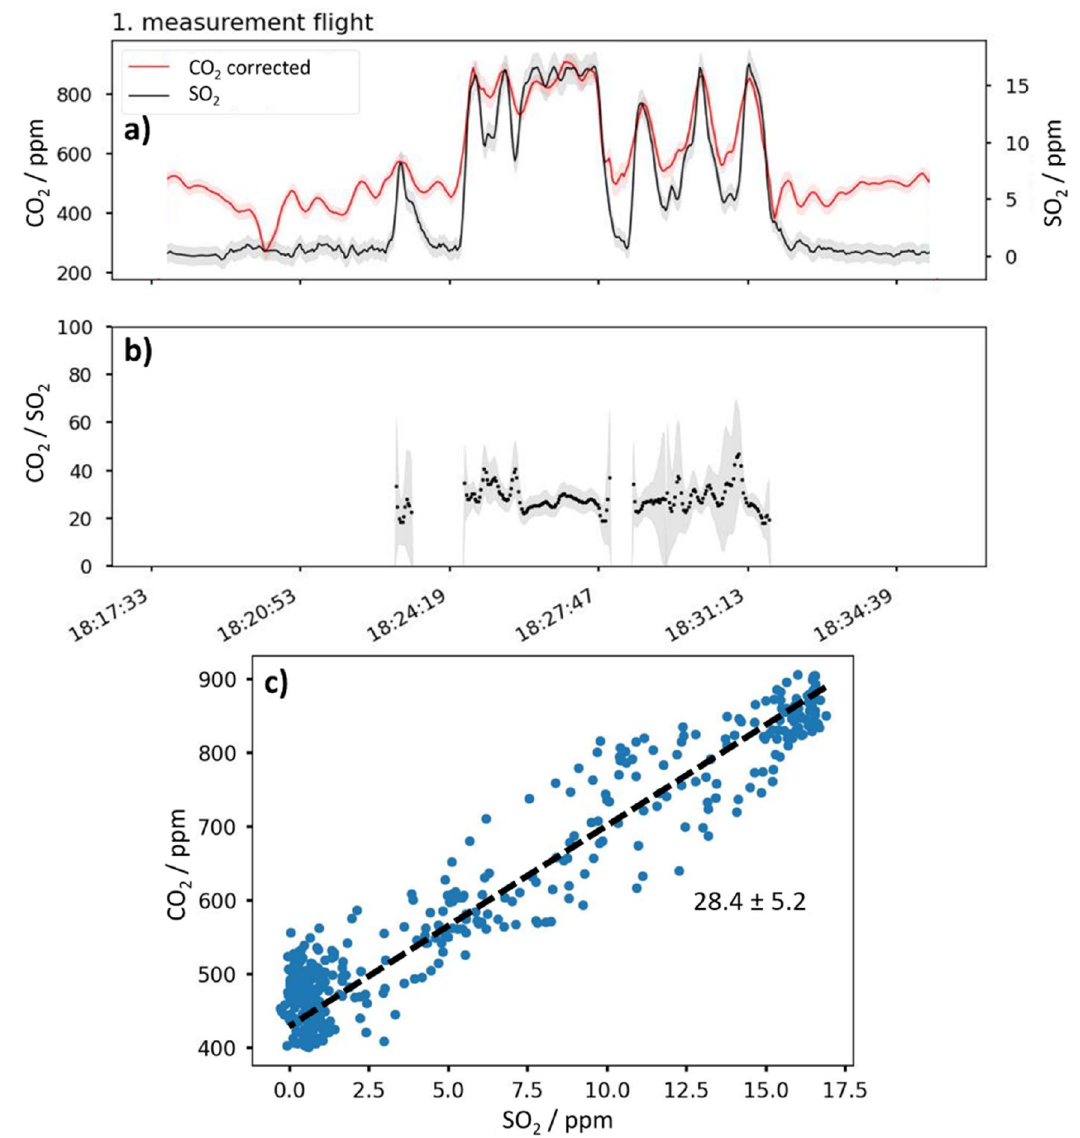
Figure 4. Concentration time profile ( a ) and excess-CO 2 /SO 2 -ratio ( b ) during measurement flight 1 (see Fig. 3, light blue flight path). The error was calculated according to the procedure described in the Supplementary Information S5. ( c ) CO 2 concentration plotted against the SO 2 concentration. All CO 2 concentrations shown in the figures are measured with the S300 sensor and subsequently response-corrected according to the procedure described in the